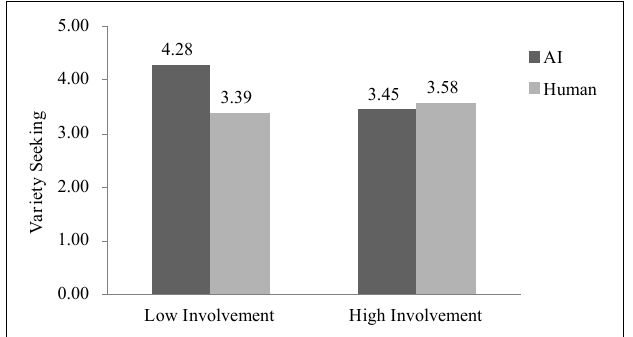
FIGURE 3 | Interaction effect on variety seeking in study 3.